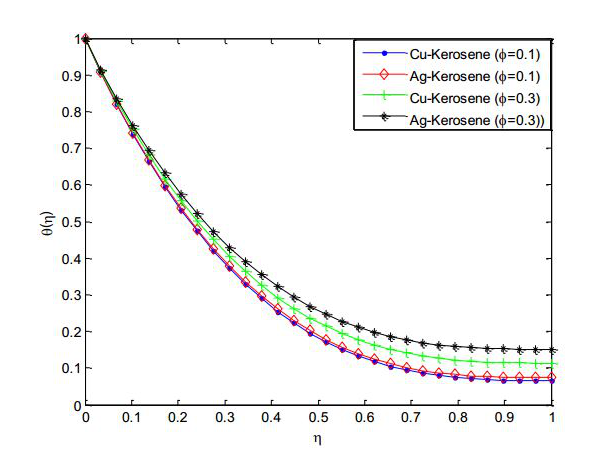
Figure 17. Effect of nanoparticle volume fractions on the fluid temperature distribution